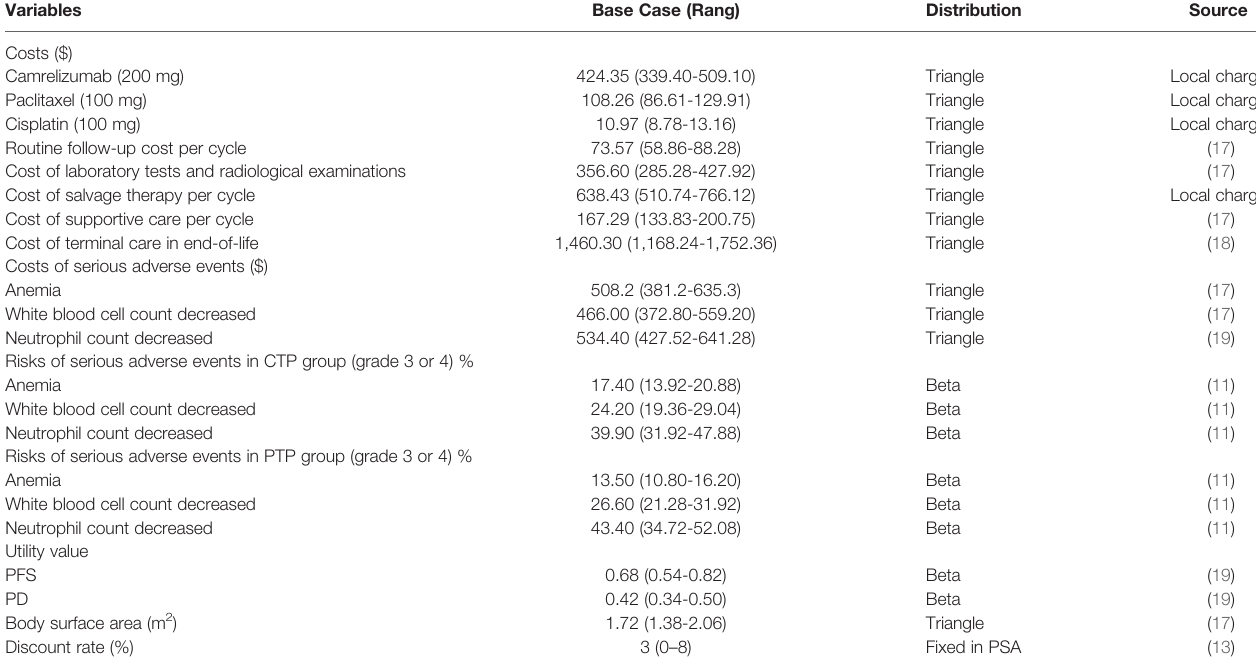
TABLE 2 | Model economic parameters and the range of the sensitivity